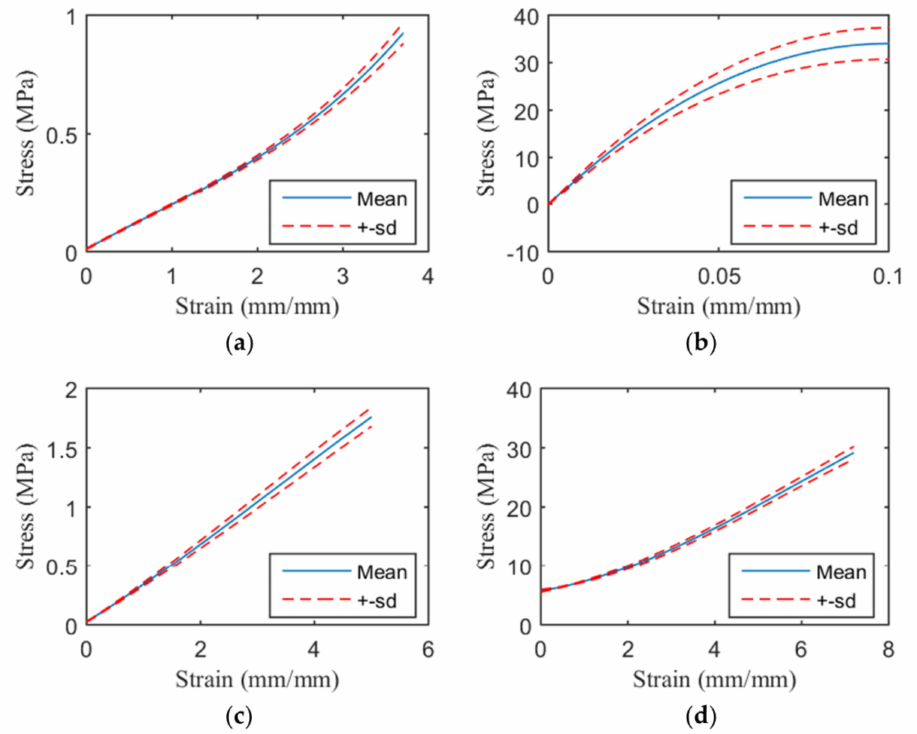
Figure 7. Stress-strain curves of the base materials. Mean stress-strain curves before yield for the: ( a ) Agilus; ( b ) VeroCyan; ( c ) Dragonskin 30; and ( d ) TPU 95A. Table 4. Mean yield stress and strain at break ( ± standard deviation) for each pattern design.